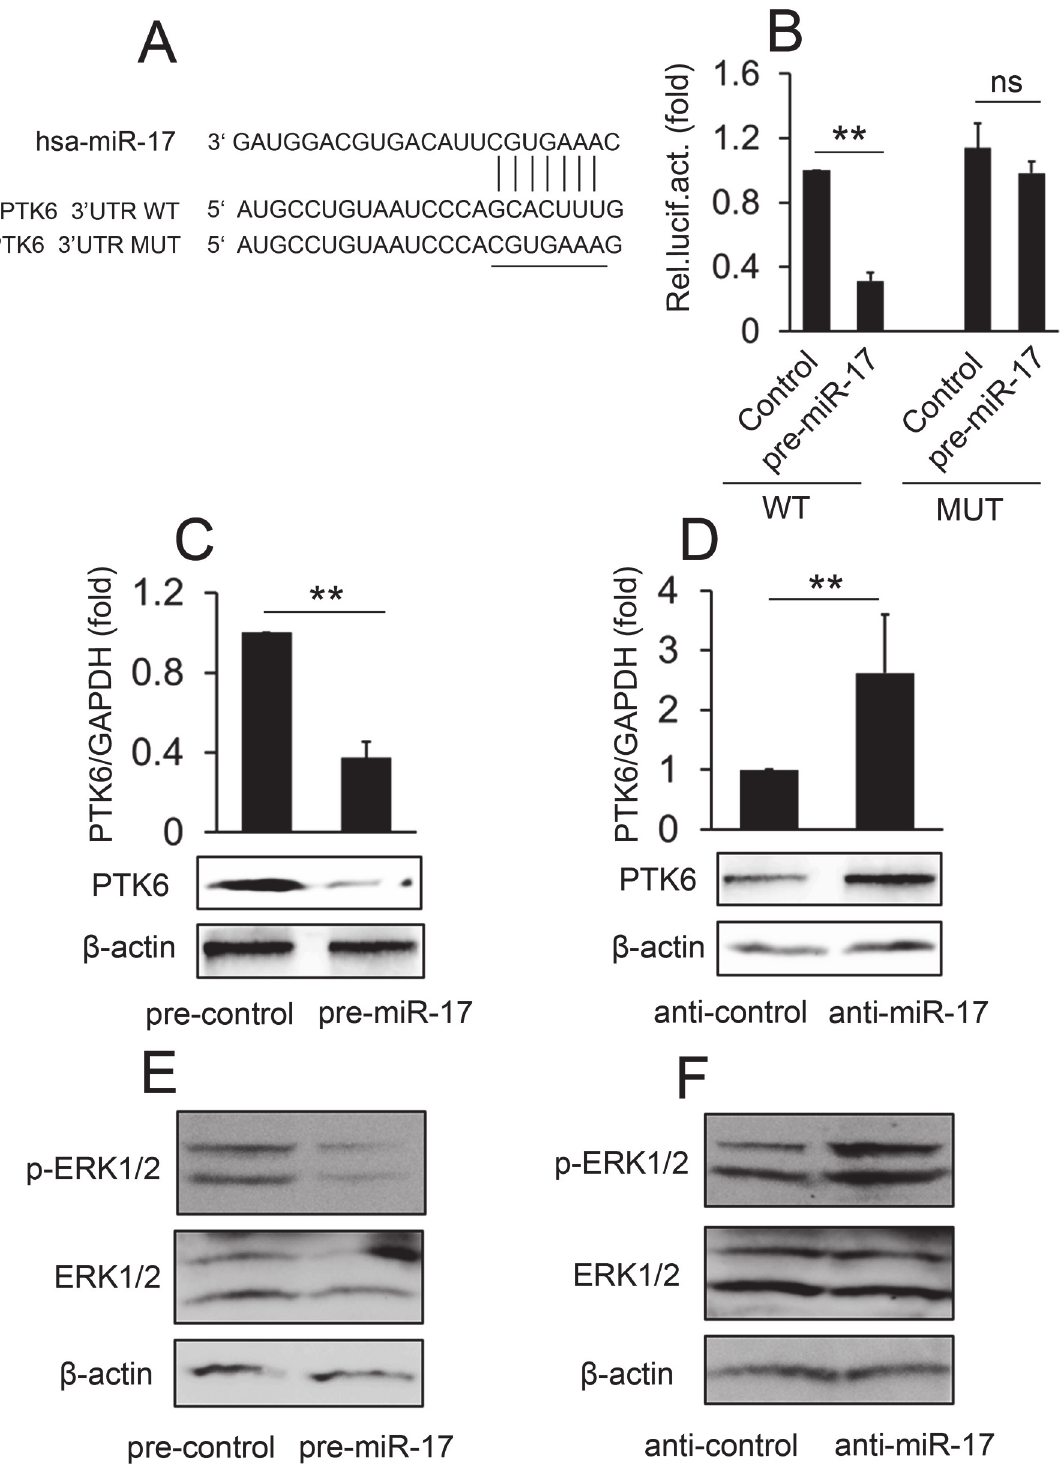
Fig 3. miR-17 down-regulates PTK6 expression by directly targeting its 3 ’ UTR. (A) The sequences of miR-17 binding sites within the human PTK6 3 ’ UTRs and schematic reporter constructs, in this panel, PTK6-WT represents the reporter constructs containing the entire 3 ’ UTR sequences of PTK6. PTK6-MUT represent the reporter constructs containing mutated nucleotides. (B) 293T cells were co-transfected with WT or MUT PTK6 3 ’ UTR reporter plasmids and pre-miR-17 for 48 hours prior to luciferase assays. (C) ML-1 cells were transfected with pre-control or pre-miR-17 for 48 hours prior to real-time